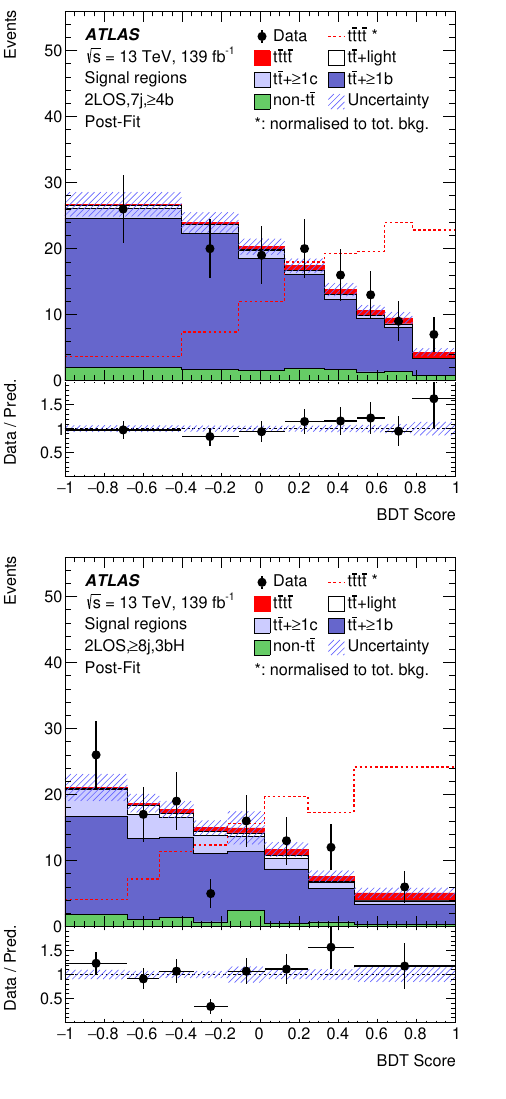
Figure 8 . Comparison between data and post-fit prediction for the distributions of the BDT score in each signal region in the 2LOS channel. The band includes the total uncertainty of the post-fit computation. The dashed red line shows the signal distribution normalised to the background yield. The ratio of the data to the total post-fit computation is shown in the lower